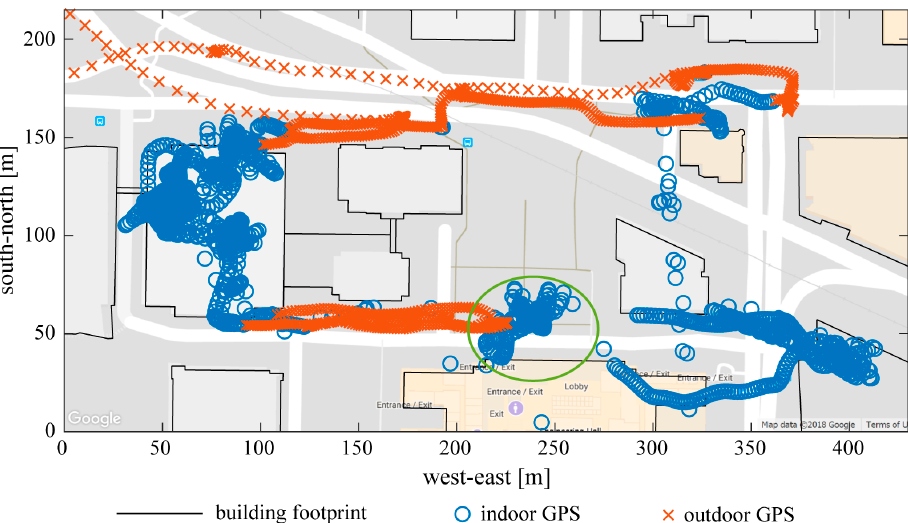
Figure 1. Indoor vs. Outdoor GPS recognition. Indoor GPS locations are indicated by blue circles; outdoor GPS locations are indicated by red crosses. Black lines are building footprints downloaded